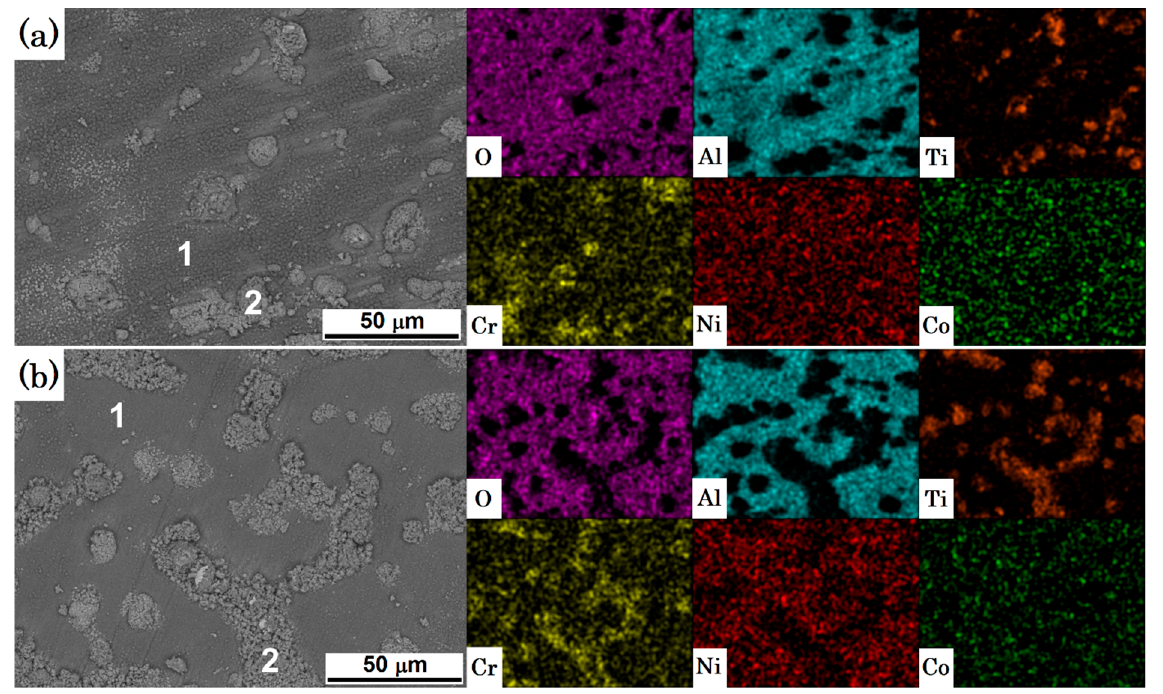
Figure 2 . SEM and EDS mapping of elements for 180 cycles at 900 °C on the top of the specimens. Figure 2. SEM and EDS mapping of elements for 180 cycles at 900 ◦ C on the top of the specimens.